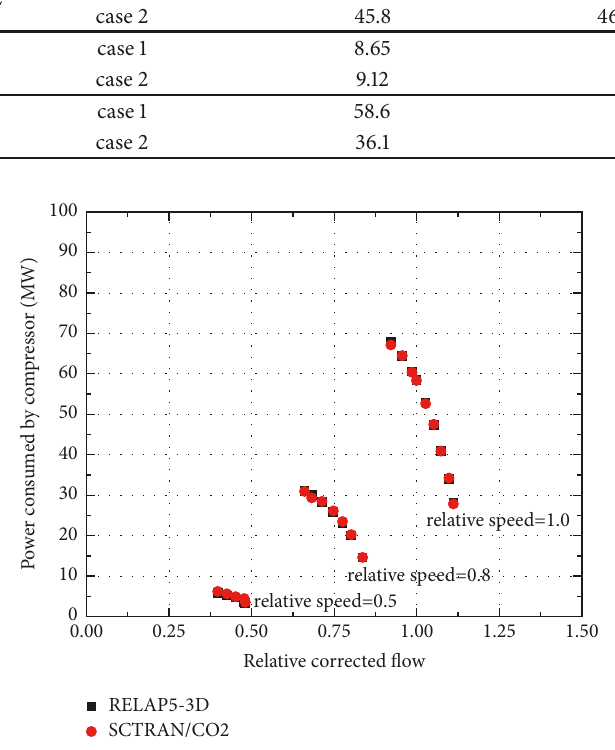
Figure 11: Predicted compressor consuming power by SCTRAN/CO2 and RELAP5-3D.